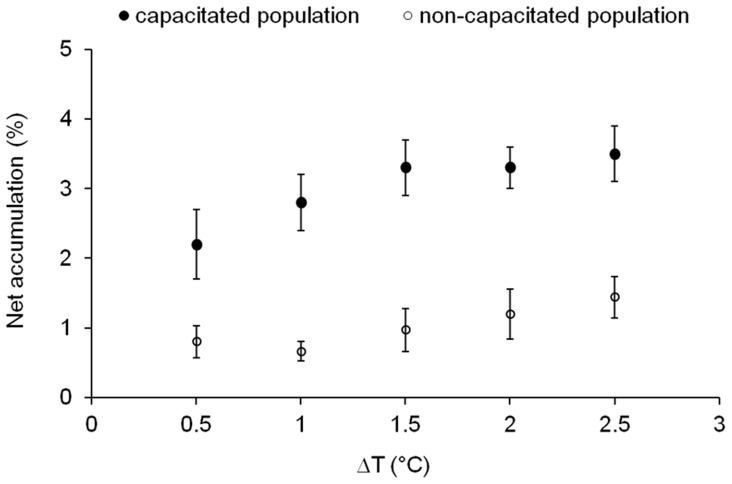
Dependence of sperm accumulation on the magnitude of the temperature difference.The temperature of the sperm-containing compartment was 36.5°C in all runs. The temperature differences shown in the abscissa were measured by the thermocouples at both ends of the tube (externally to the tube). Net accumulation was calculated by subtracting the no-gradient control accumulation from the sperm accumulation in a temperature gradient. The results are the mean ± SEM of 7–9 determinations (3–5 experiments). The difference between capacitated and non-capacitated sperm is very significant (P<0.0001, according to one-way ANOVA with Tukey-Kramer Multiple Comparisons post-test).